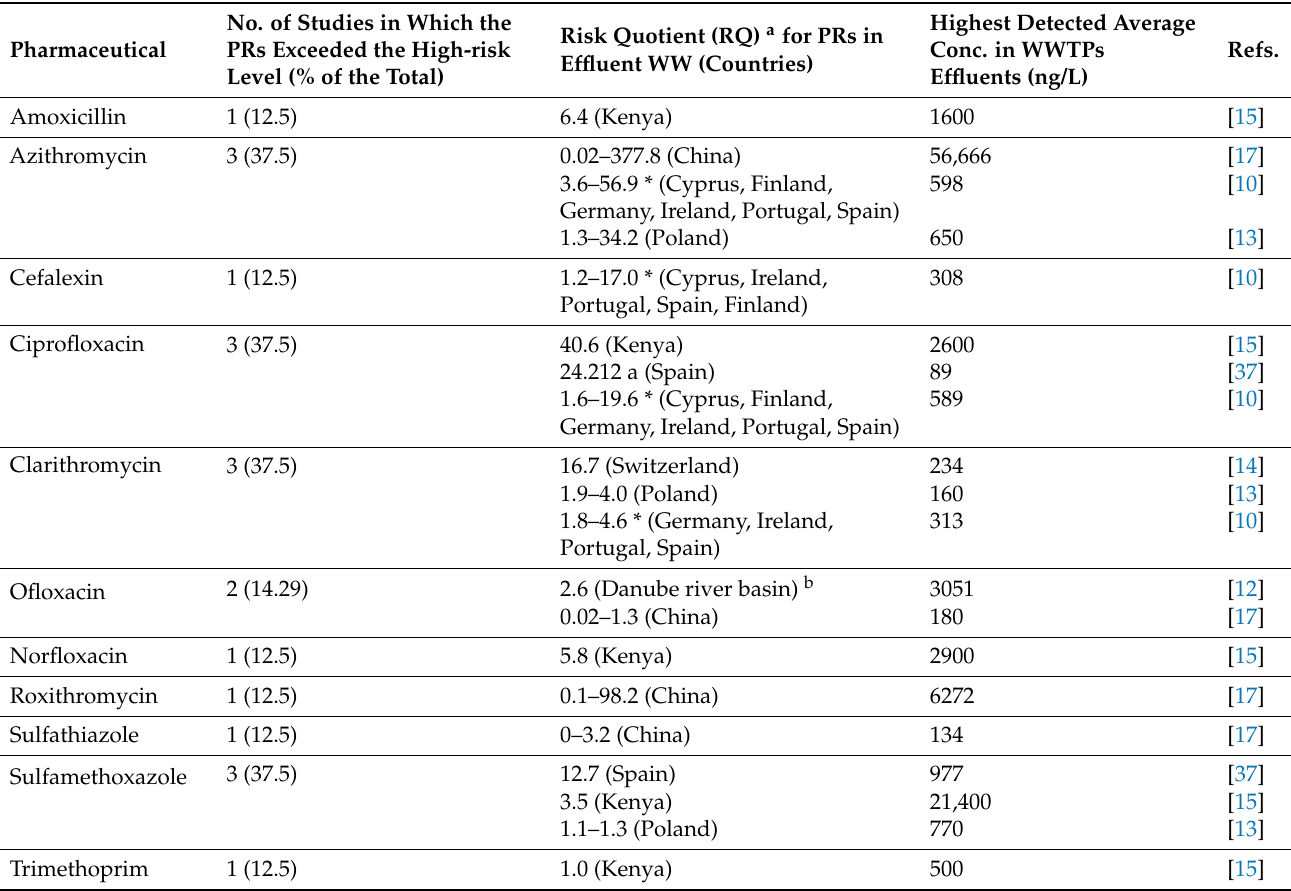
Table 6. Environmental risk assessment for PRs that posed a high risk to the